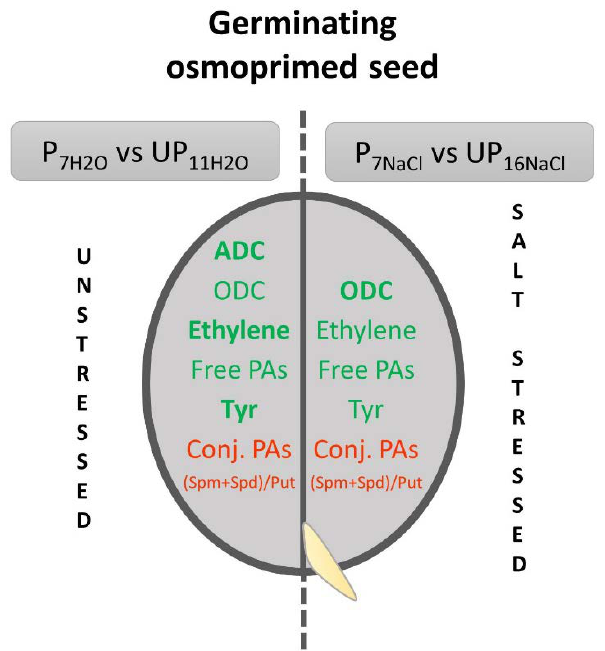
Figure 6. The summary of changes observed in the germinating osmoprimed Brassica napus seeds revealed in the present study. Stimulated/increased parameters in the germinating primed vs. unprimed variants are marked in green, whereas inhibited/decreased are marked in red. More intense changes between primed and unprimed seeds are in bold.